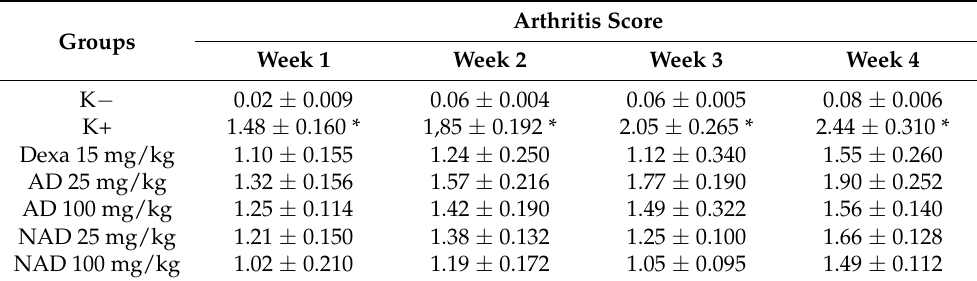
Table 4. Arthritis score for andaliman extract and nanoandaliman in CFA-induced